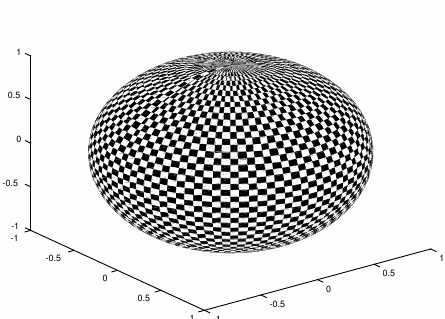
Figure 2. Linear observation operator during assimilation steps. Shaded regions denote observed components (observations) from the model state. The operator is replicated across all numerical